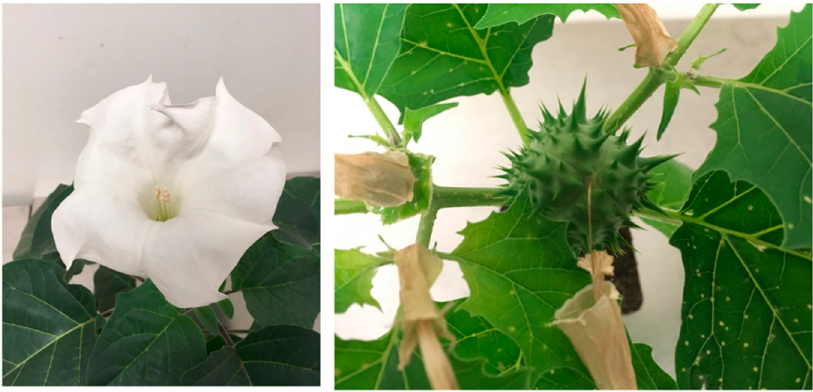
Figure 2. Flower of D. metel ( left ) and fruit of D. stramonium var. stramonium ( right